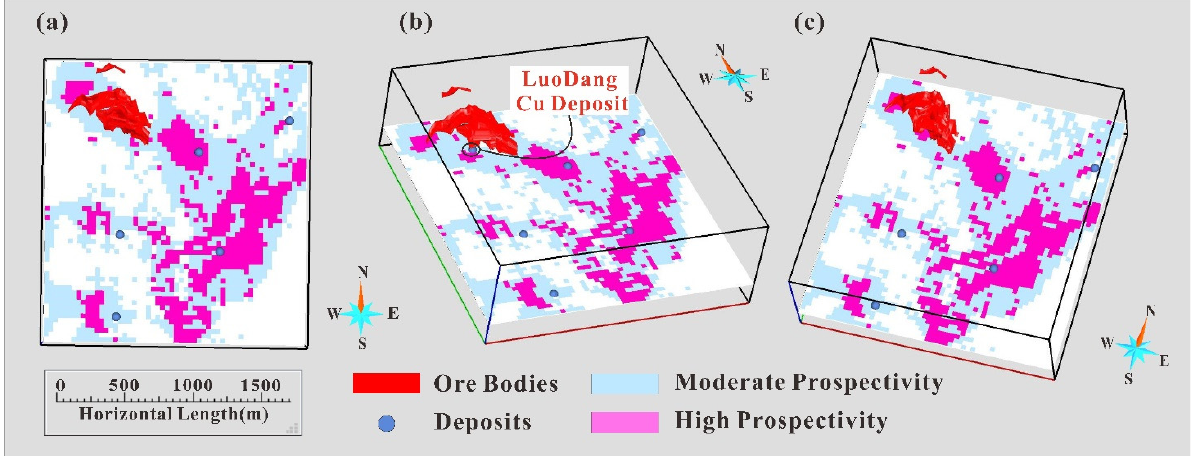
Figure 13. Superposition map of the ore body model and metallogenic prospect area. ( a ) Top View; ( b ) Left view; ( c ) Right view.